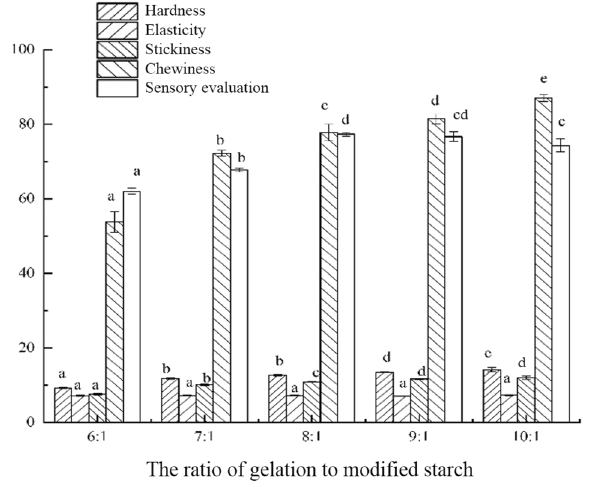
Fig. 1 Effect of gelatin and modified starch on the quality of gelatin